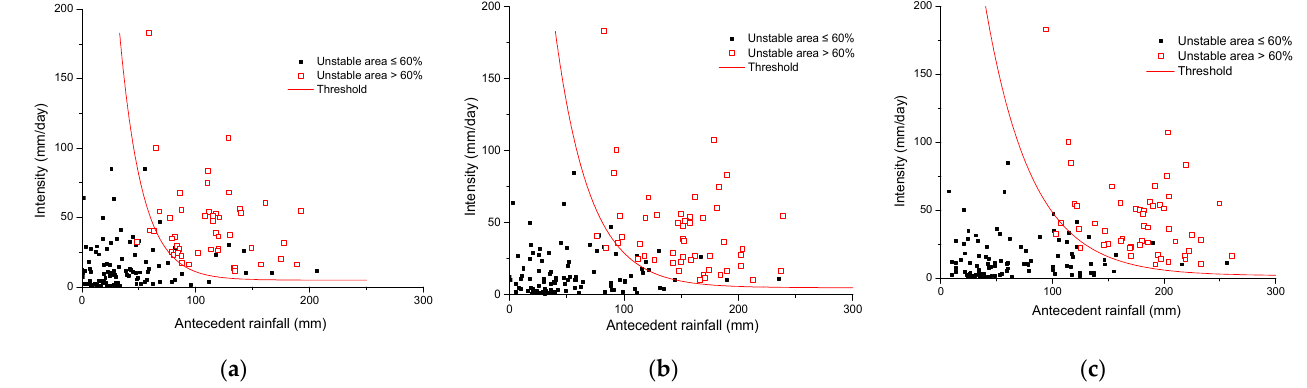
Figure 8. The scatter graph of rainfall intensity and different antecedent rainfall. ( a ) 5-day antecedent rainfall, ( b ) 10-day antecedent rainfall, ( c ) 15-day antecedent rainfall.